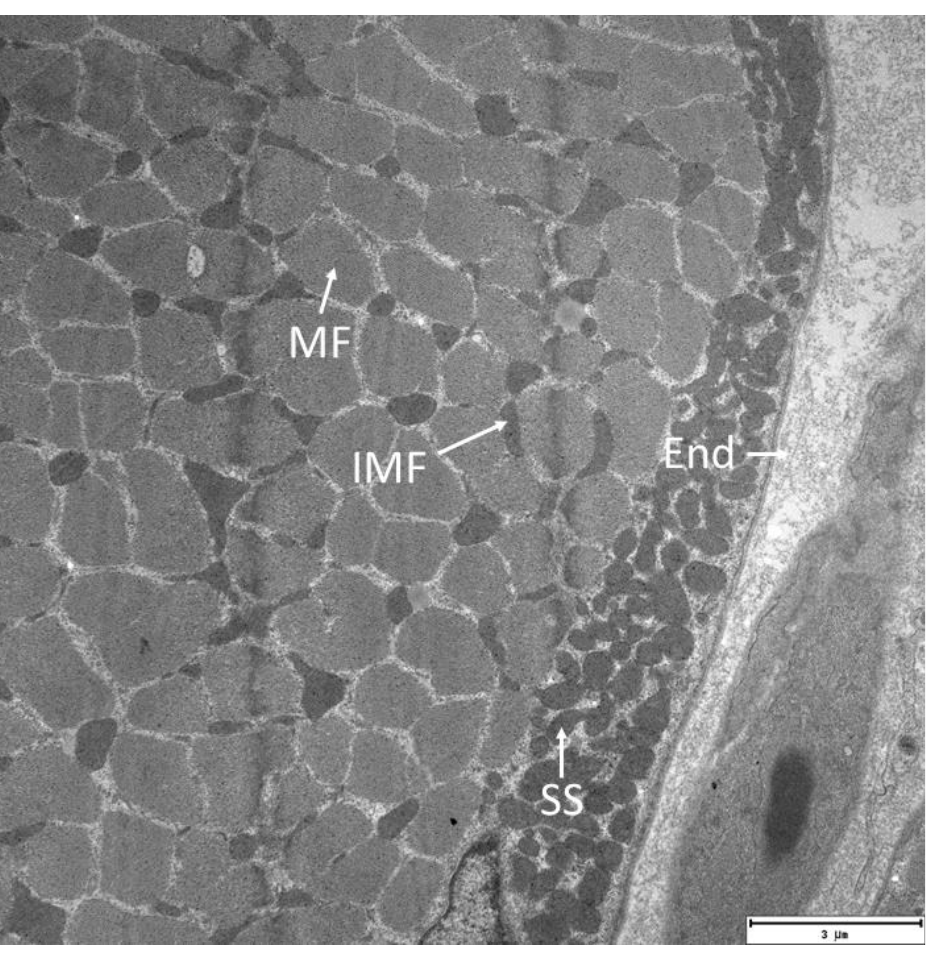
Figure 5. Representative electron micrograph of human gastrocnemius muscle from a subject participating in the present study. The electron microscopy image depicts subsarcolemmal (SS) and intermyofibrillar (IMF) mitochondria. MF, muscle fiber; End, endomysium.